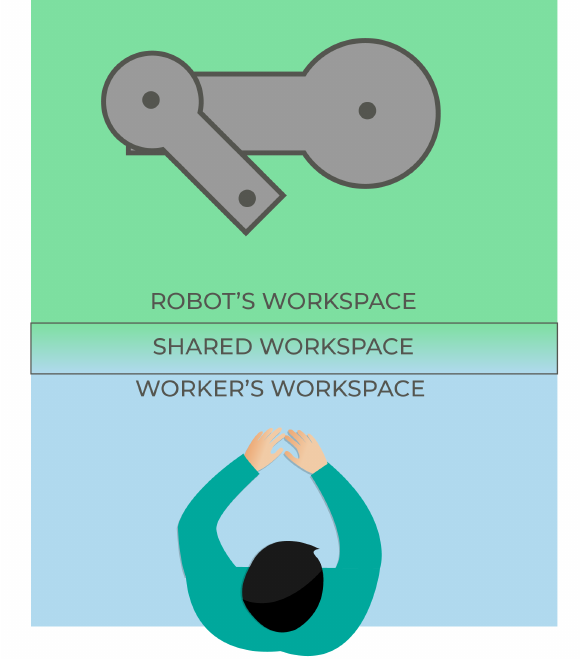
Figure 1. Workers’ and robots’ workspaces.